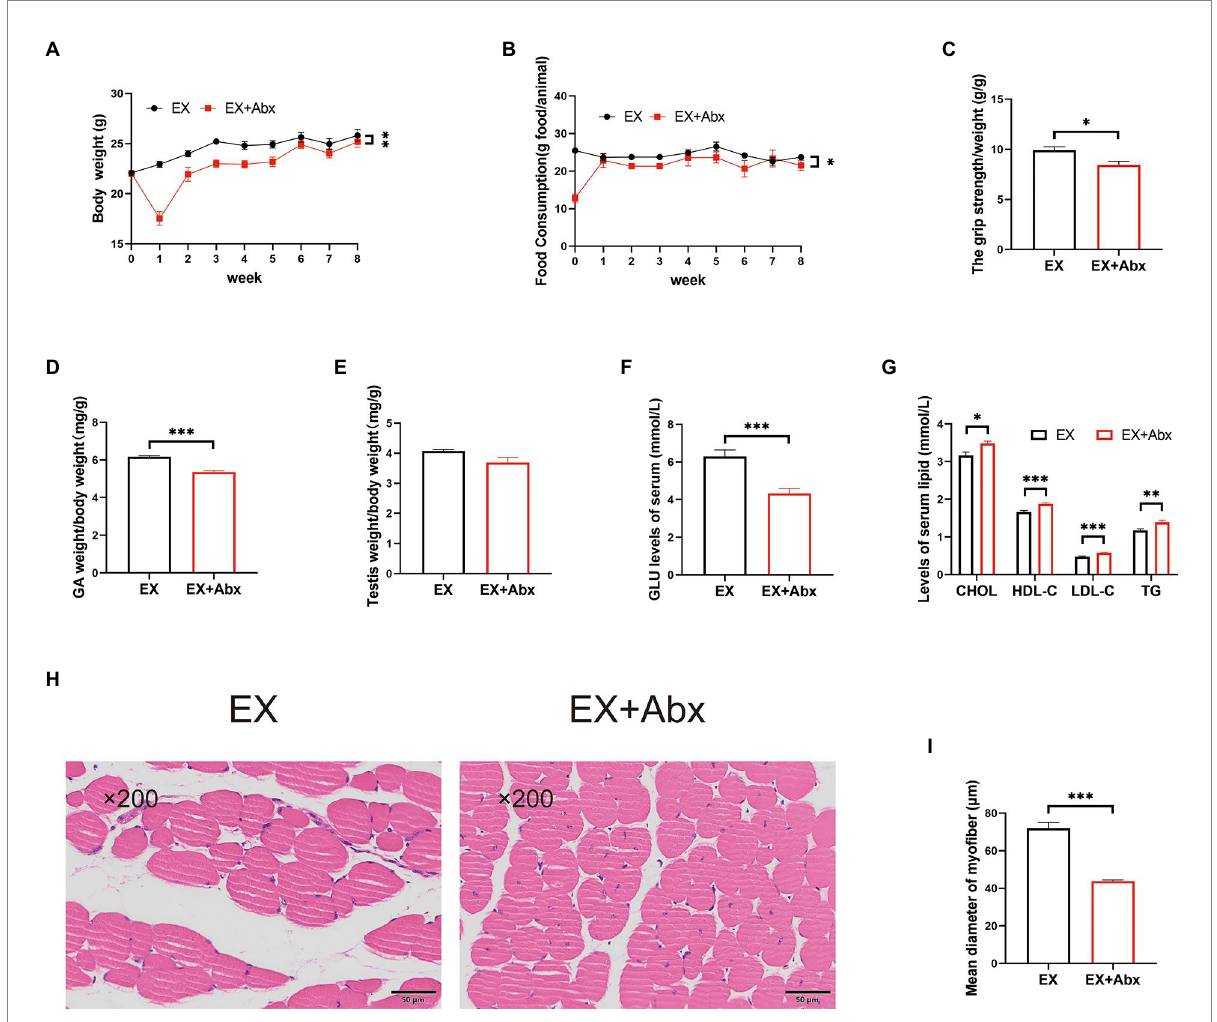
FIGURE 4 The high-intensity aerobic exercise disappeared after the elimination of the gut microbiota (EX vs. EX+Abx). (A) Body weight. (B) Food intake. (C) Grip strength. (D) GA percentage. (E) Testis percentage. (F) Serum GLU levels. (G) Serum lipids levels. (H) Histological staining of the skeletal muscle. (I) Mean diameter of the myofiber ( ∗ p < 0.05; ∗∗ p < 0.01; ∗∗∗ p <